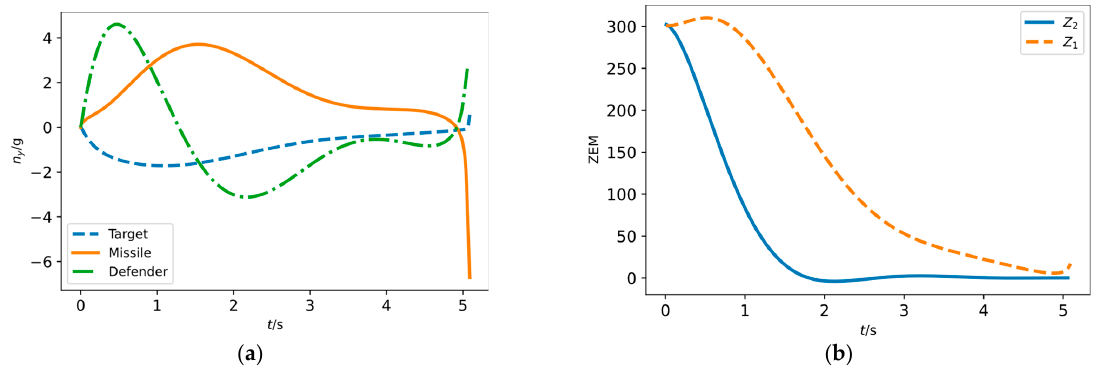
Figure 8. Block diagram of proportional navigation guidance system. ( a ) Original guidance system; ( b ) Adjoint guidance system.